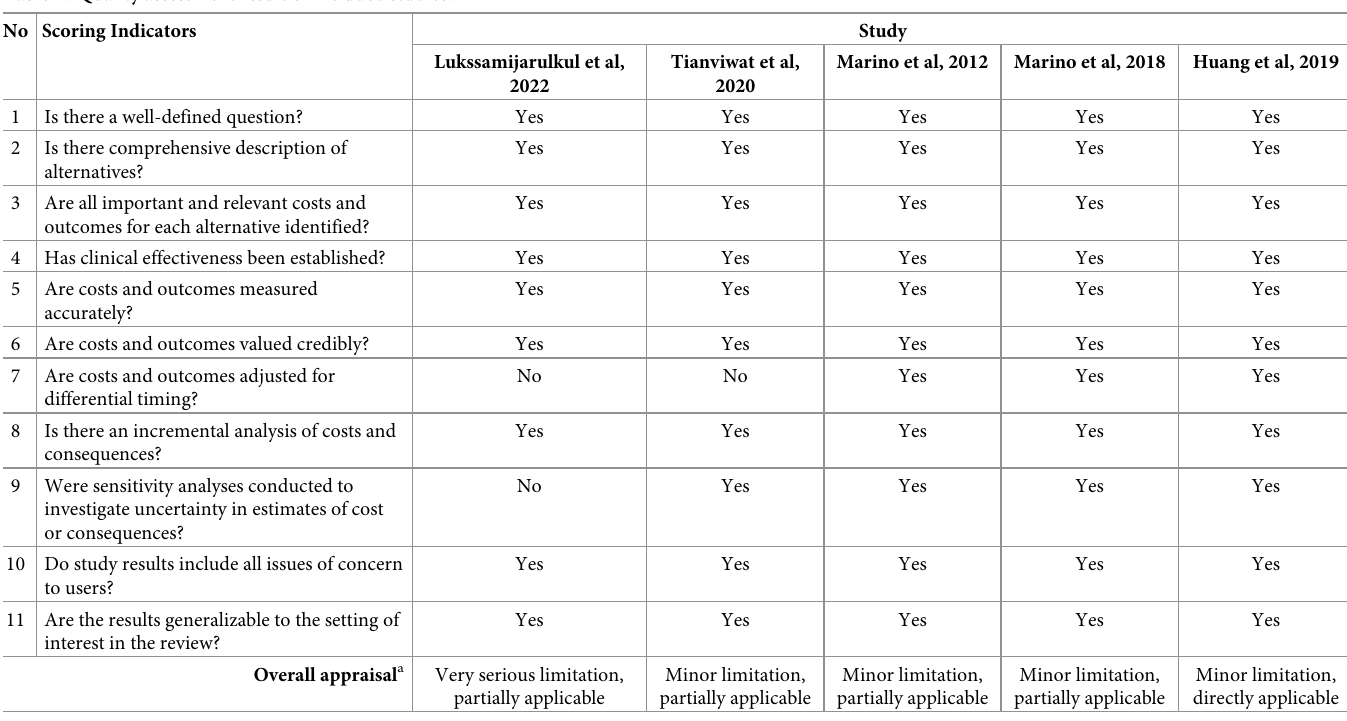
Table 1. Quality assessment result of included